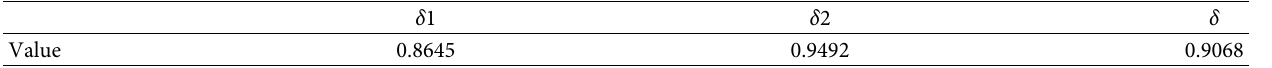
Table 12: .e consensus threshold without considering the interactive weights.